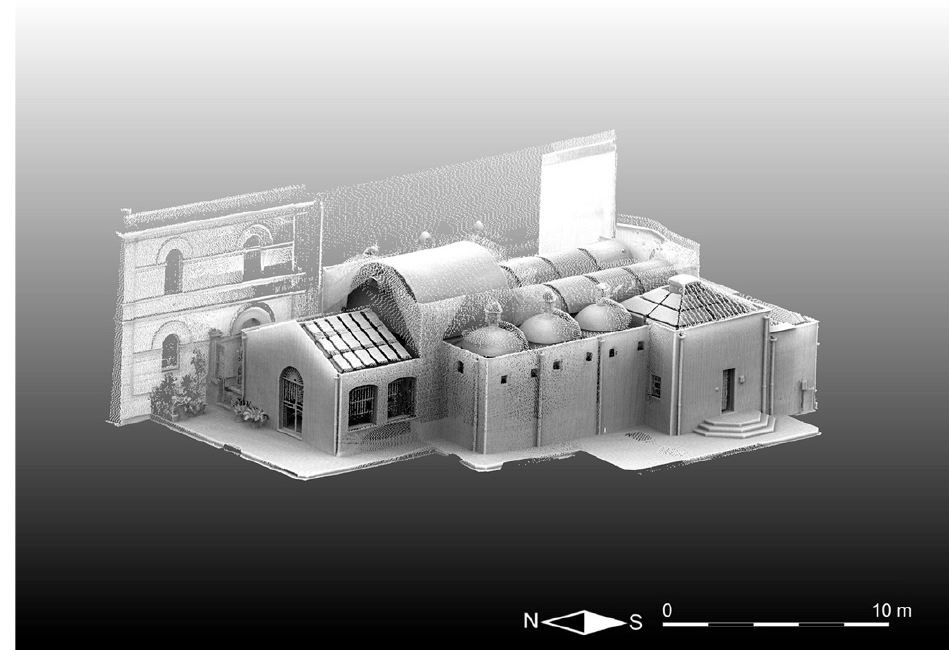
Figure 9. Unified, filtered, registered, unstructured point cloud texturized with the intensity that represents the high-resolution 3D model of the church of Saints Lorenzo and Pancrazio computed after TLS data processing.